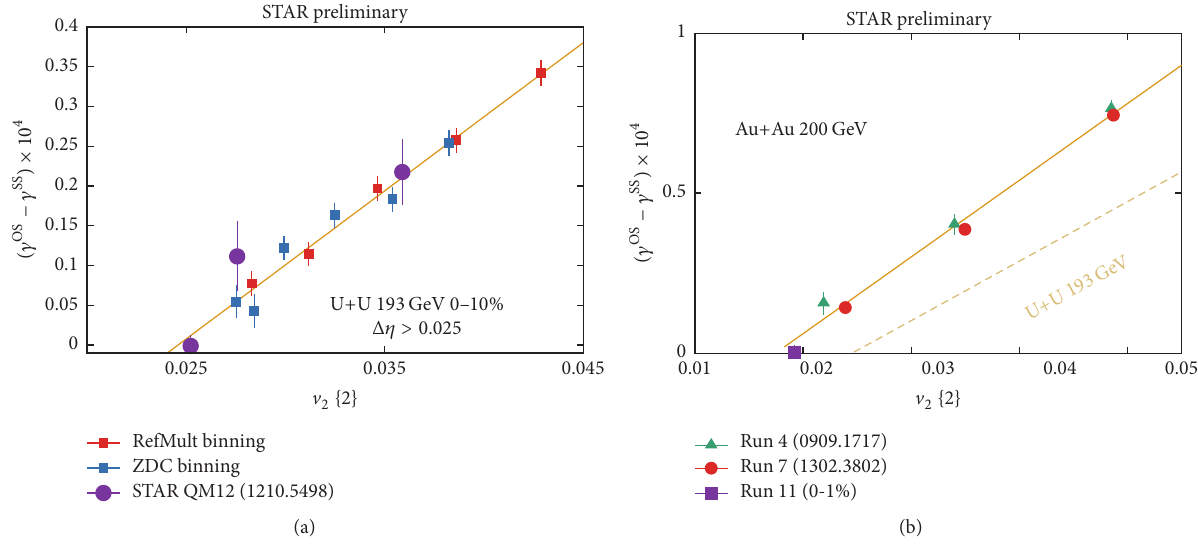
Figure 10: Δ𝛾 as a function of V 2 for various centrality selections within the 0–10% centrality range in U+U collisions (a) and Au+Au collisions (b)